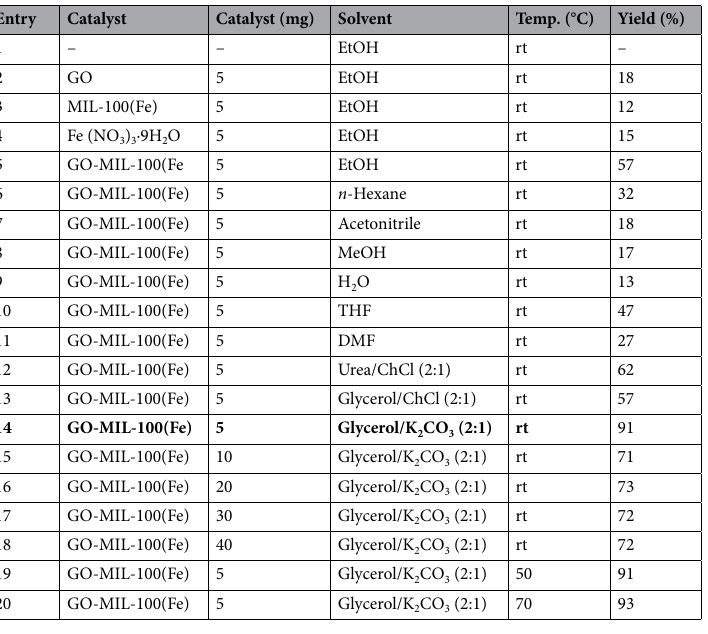
Table 2. Optimization track of the catalysts used in the PAOF. According to the TGA analysis, GO-MIL- 100(Fe) composite with 38.5/61.5 (w%/w%) ratio of graphene oxide to MIL-100(Fe) was selected as the most efficient catalyst in photocatalytic condensation reaction at r.t. in (Glycerol/K 2 CO 3 (2:1) (DES) as reaction medium). Significant values are in